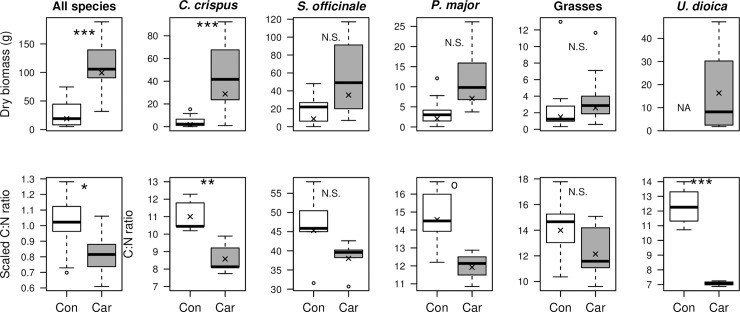
Vegetation biomass (top row) and nutritional quality (bottom row) responses to carrion presence after five months of decomposition (dry stage). Nutritional quality was calculated as C:N ratio of leaf or stem material. Crosses represent arithmetic means. Note that because of low power (low sample size) of some tests, large effect sizes do not always provide p-values <0.05. The test statistics and power of all tests are provided in Table 2. Stars denote significant differences: o = P < 0.1; * = P < 0.05; ** = P <0.01; *** = P < 0.001; N.S. = P > 0.1. Plant species: Carduus crispus, Sisymbrium officinale, Plantago major, and Urtica dioica. ‘Con’ = control sites, ‘Car’ = carrion sites.